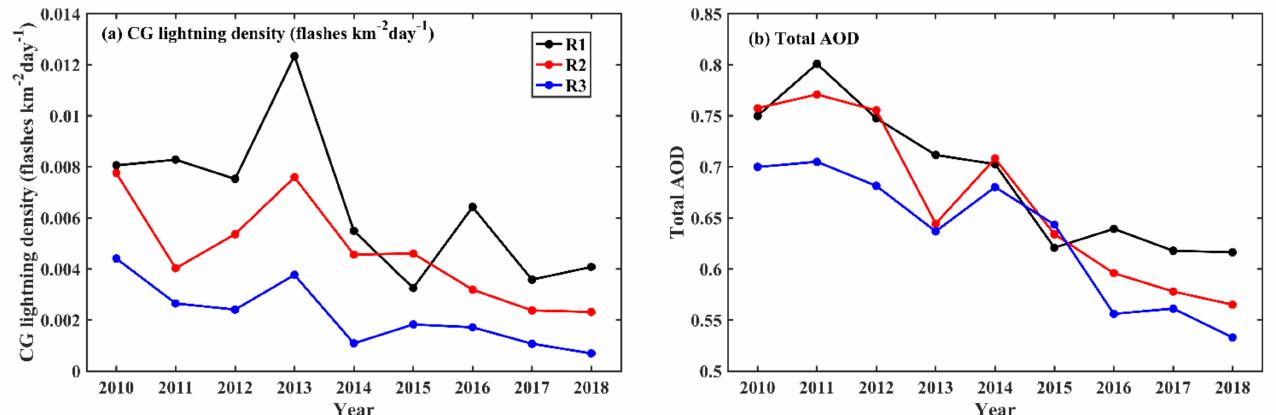
Figure 4. Interannual variations of ( a ) CG lightning density (unit: flashes km − 2 day − 1 ) and ( b ) total AOD during 2010–2018 over three study regions (R1, R2, and R3). All AOD data are derived from